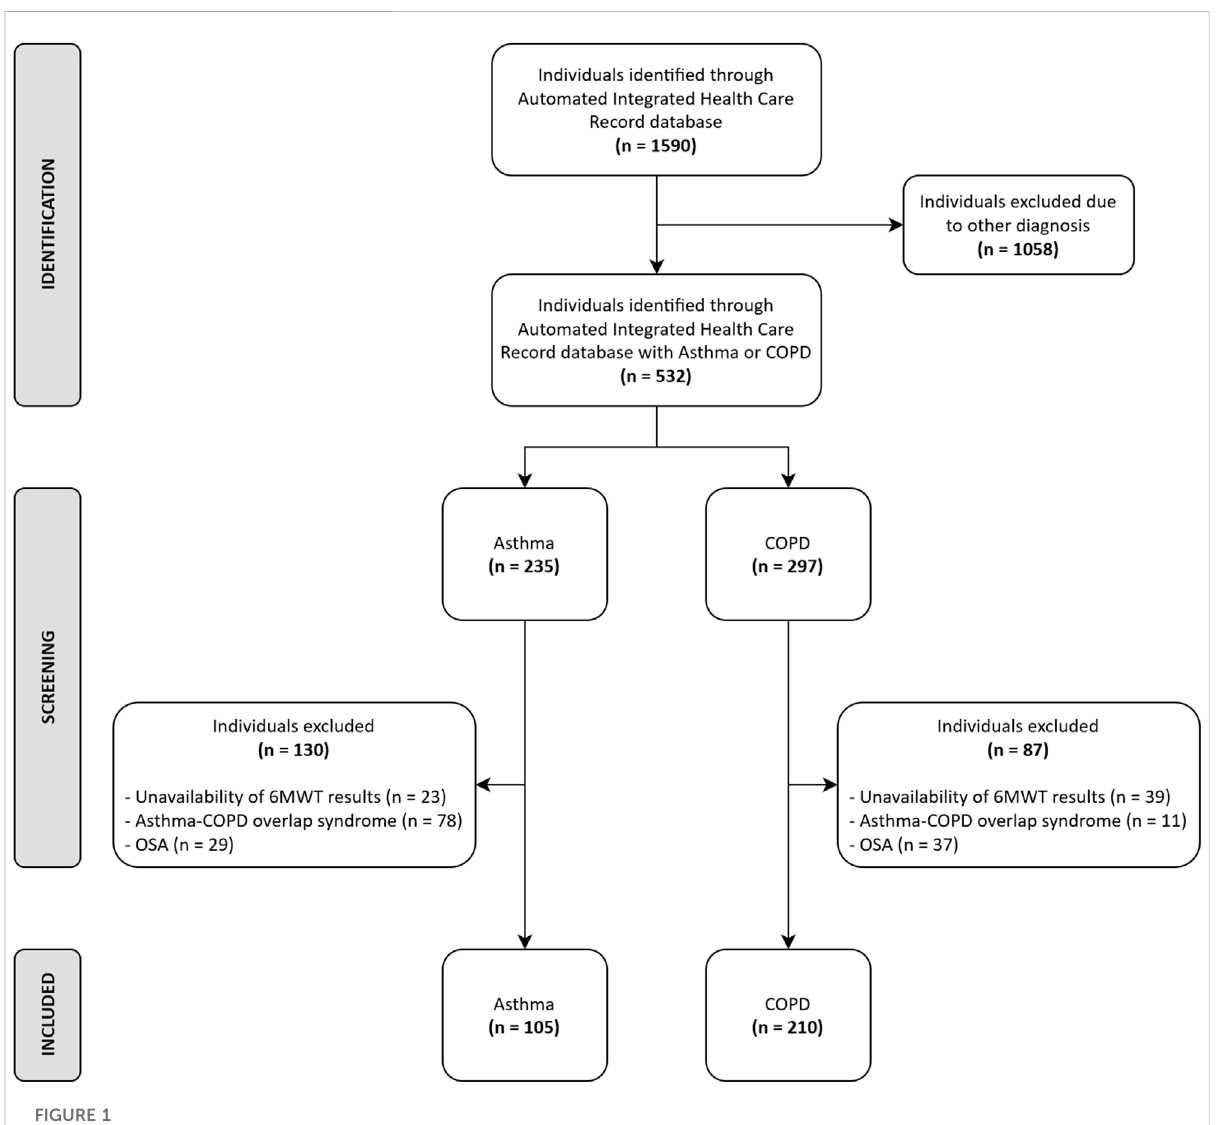
FIGURE 1 Patient inclusion fl